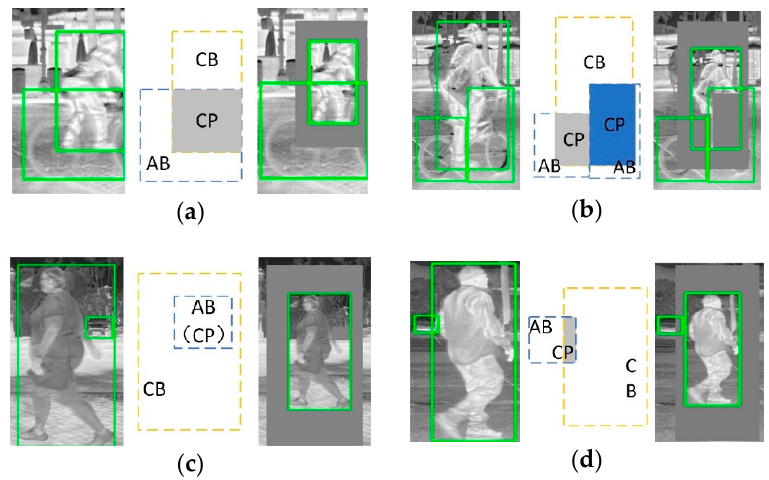
Figure 4. Examples of two ratios. CP: common part, CB: current box, AB: another box.